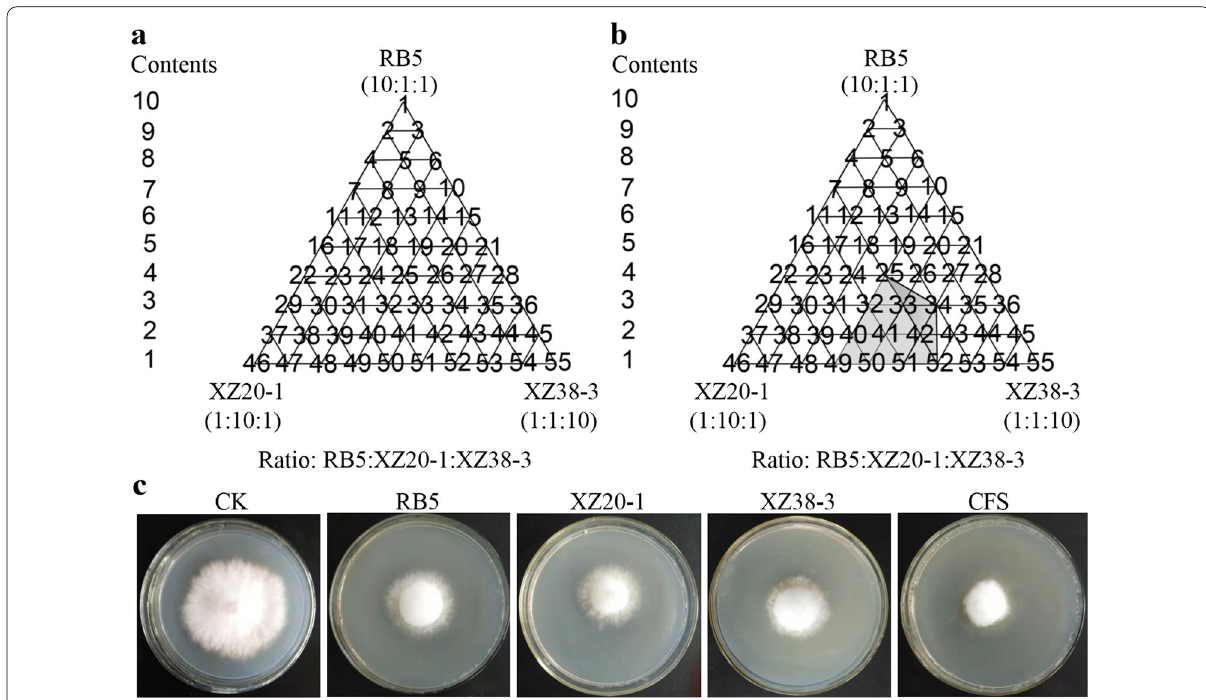
Fig. 3 Ratio of three strains and inhibition effects of fermentation supernatants . a Ratio of strains in the improved triangular coordinate diagram; b The optimal compound ratios shown in the triangular coordinate diagram; c Inhibition effects of fermentation supernatants of strains on Rhizoctonia